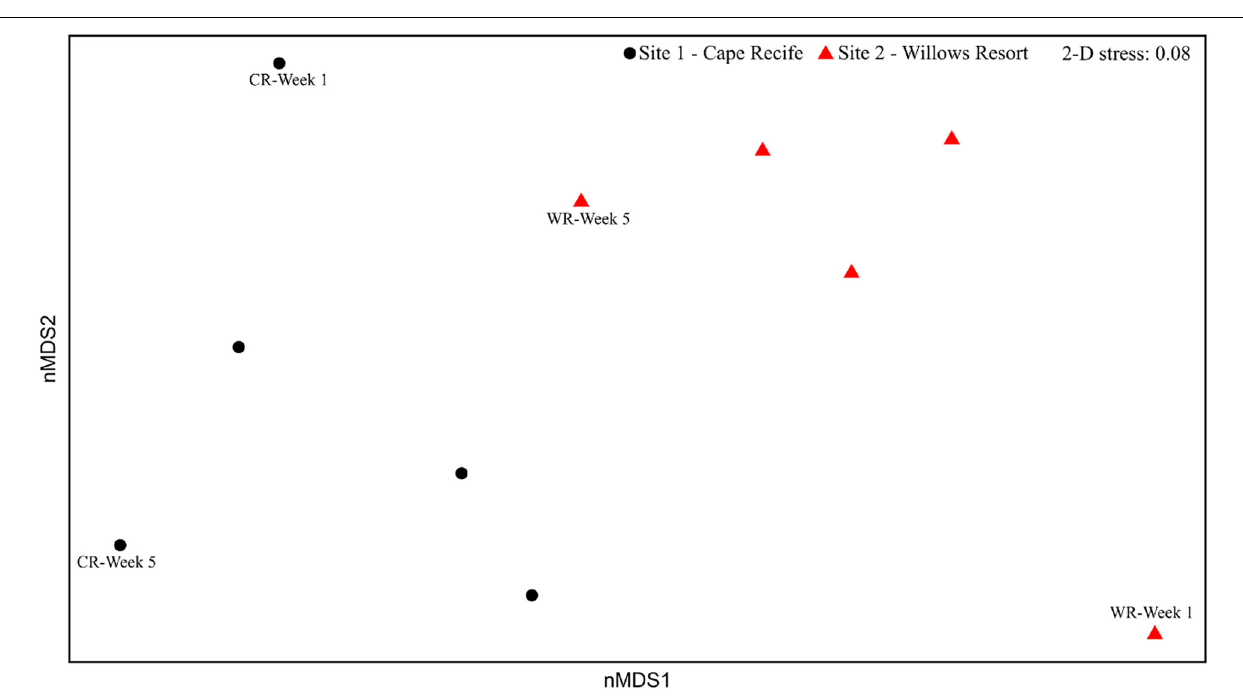
Frontiers in Ecology and Evolution |